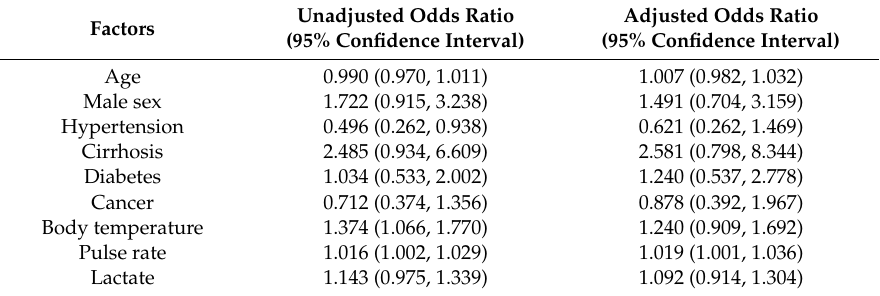
Table 3. Predictors of appropriate use of antibiotics in patients presenting with bacteremia at the emergency department.